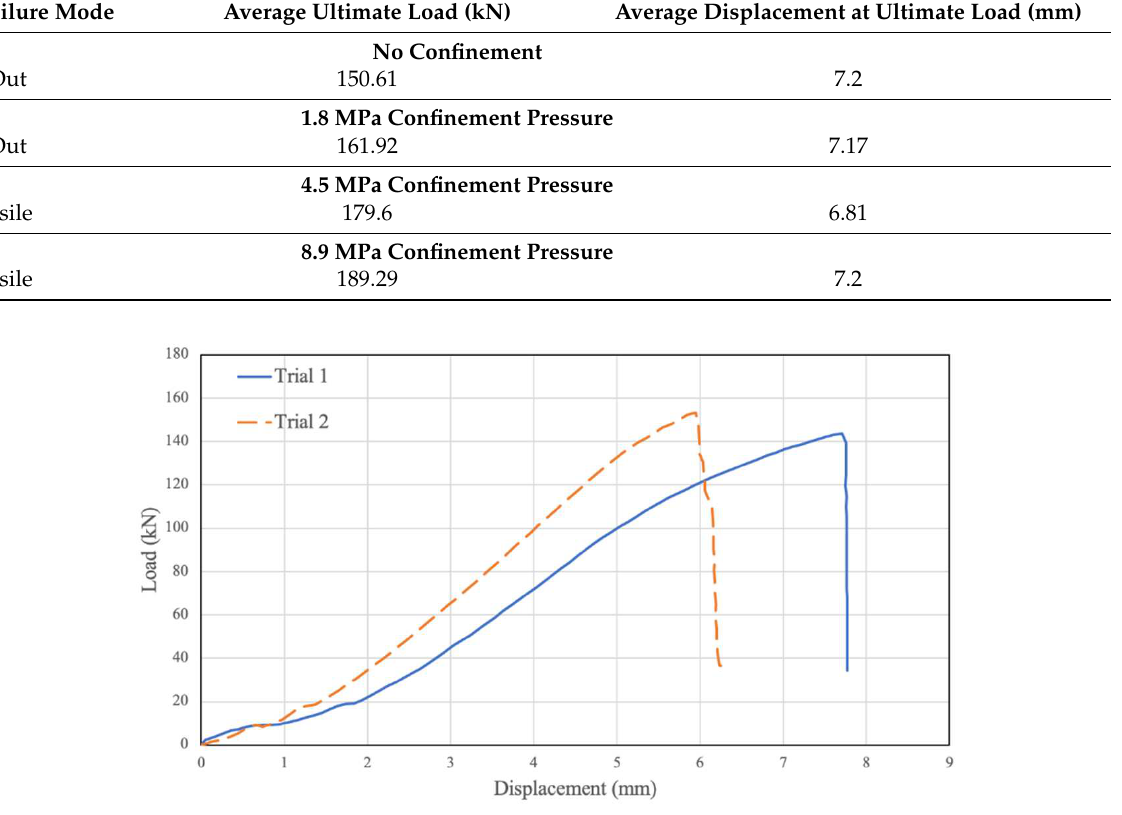
Figure 7. Unconfined 0 MPa Displacement vs. Load.